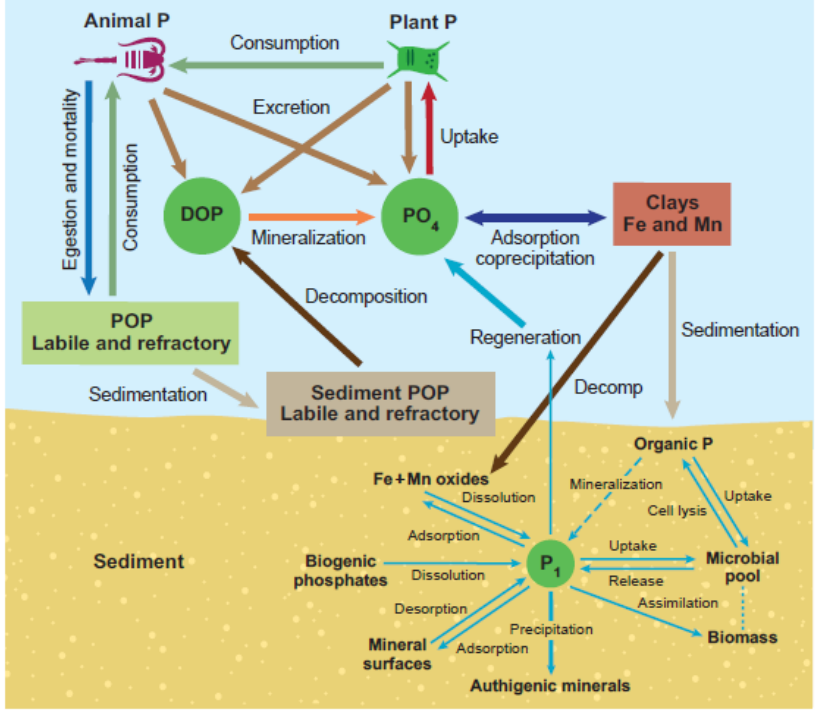
Figure 3. The P cycle showing both biotic and abiotic components including i nteractions with the Fe and S